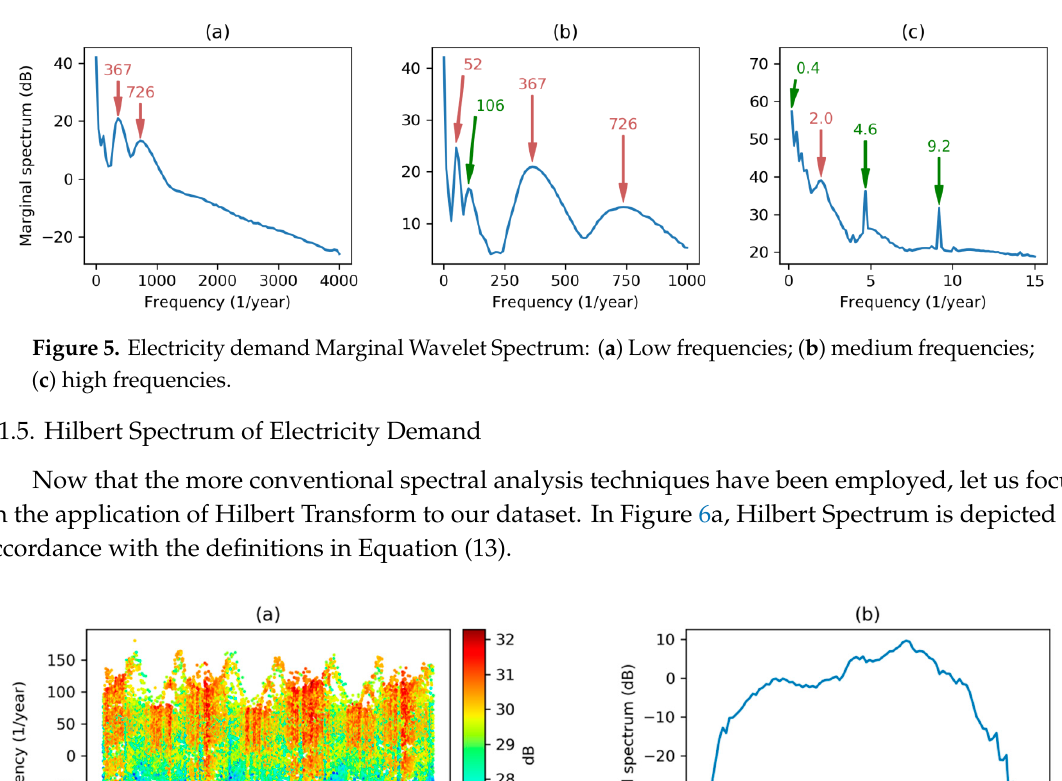
8 of 25 Figure 3. Electricity demand Short-Time Fourier Transform (STFT) spectrogram at different frequency scales and resolutions: ( a ) Full spectrogram, 𝛥𝑡 = 1 𝑤𝑒𝑒𝑘 ; ( b ) low frequency spectrogram, 𝛥𝑡 = 1 𝑤𝑒𝑒𝑘 ; ( c ) low frequency spectrogram, 𝛥𝑡 = 0.5 𝑦𝑒𝑎𝑟𝑠 . To increase frequency resolution, the width of the window function has to be enlarged and, consequently, the time resolution decreases. Figure 3c depicts the result when a 𝛥𝑡 = 0.5 𝑦𝑒𝑎𝑟𝑠 is applied, resulting in a frequency resolution of Δ𝑓 = 2 𝑦𝑒𝑎𝑟𝑠 −1 . 3.1.3. Wavelet Transform of Electricity Demand To overcome the limitations of STFT regarding the time – frequency resolution, a Morlet WT is applied to the sequence according to Equation (6), obtaining the scalogram shown in Figure 4a. For an easier reading, the vertical axis has been converted from scale 𝑠 to frequency. Again, the electricity demand frequency representation shows a quite stationary behavior, although a small decrease during summer can be noted in the highest frequencies. Several harmonics clearly appear in the plot, centered around 50, 400, and 750 𝑦𝑒𝑎𝑟𝑠 −1 . Figure 4b presents a detail of the scalogram for the lower frequencies. Figure 4. Electricity demand Wavelet Transform (scalogram): ( a ) Including high frequencies; ( b ) low frequency detail. 3.1.4. Marginal Wavelet Transform of Electricity Demand